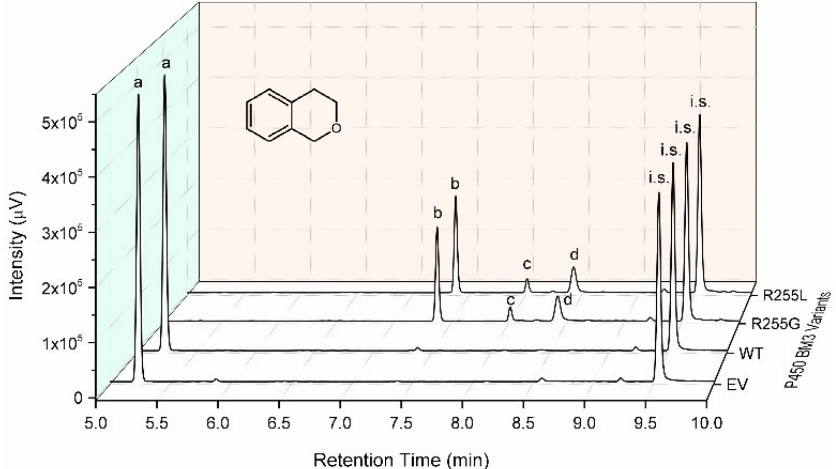
Figure A12. Product analysis via GC-FID after conversion of isochroman with lysate from EV (negative control), P450 BM3 WT, and from variants R255G and R255L. The data was obtained from 1 h conversion reactions employing GDH for efficient NADPH cofactor regeneration. a—isochroman,